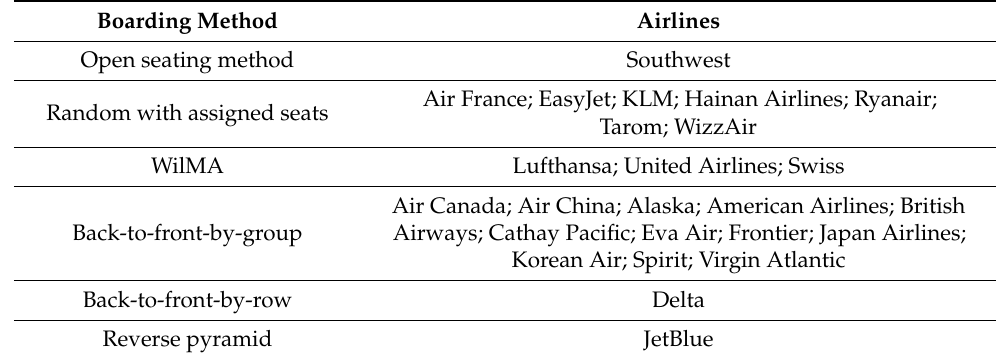
Table 1. Boarding methods used by various airlines [6,9,23,27,38,39].